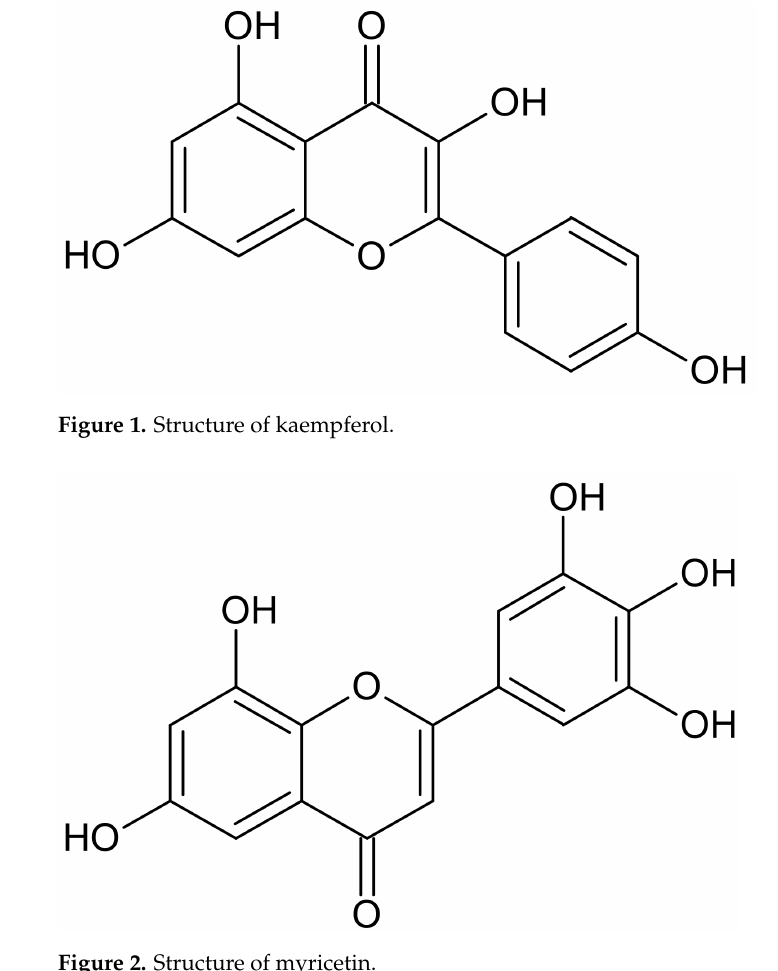
Figure 2. Structure of